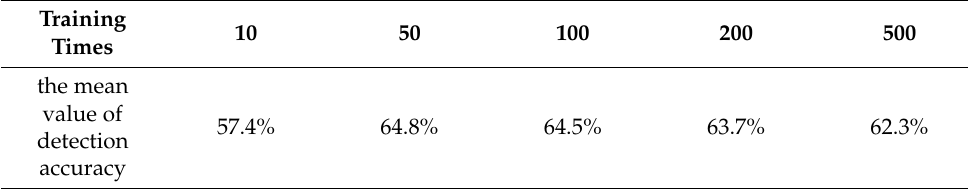
Table 7. The mean value of detection accuracy.